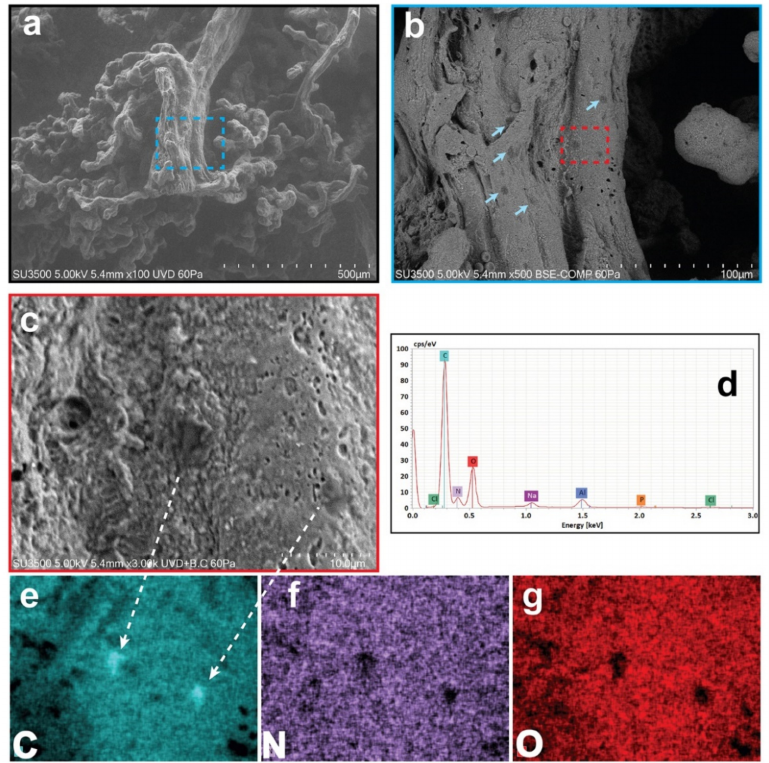
Figure 1. Surface morpho-chemical study of MPs on stem villus in hydrated human